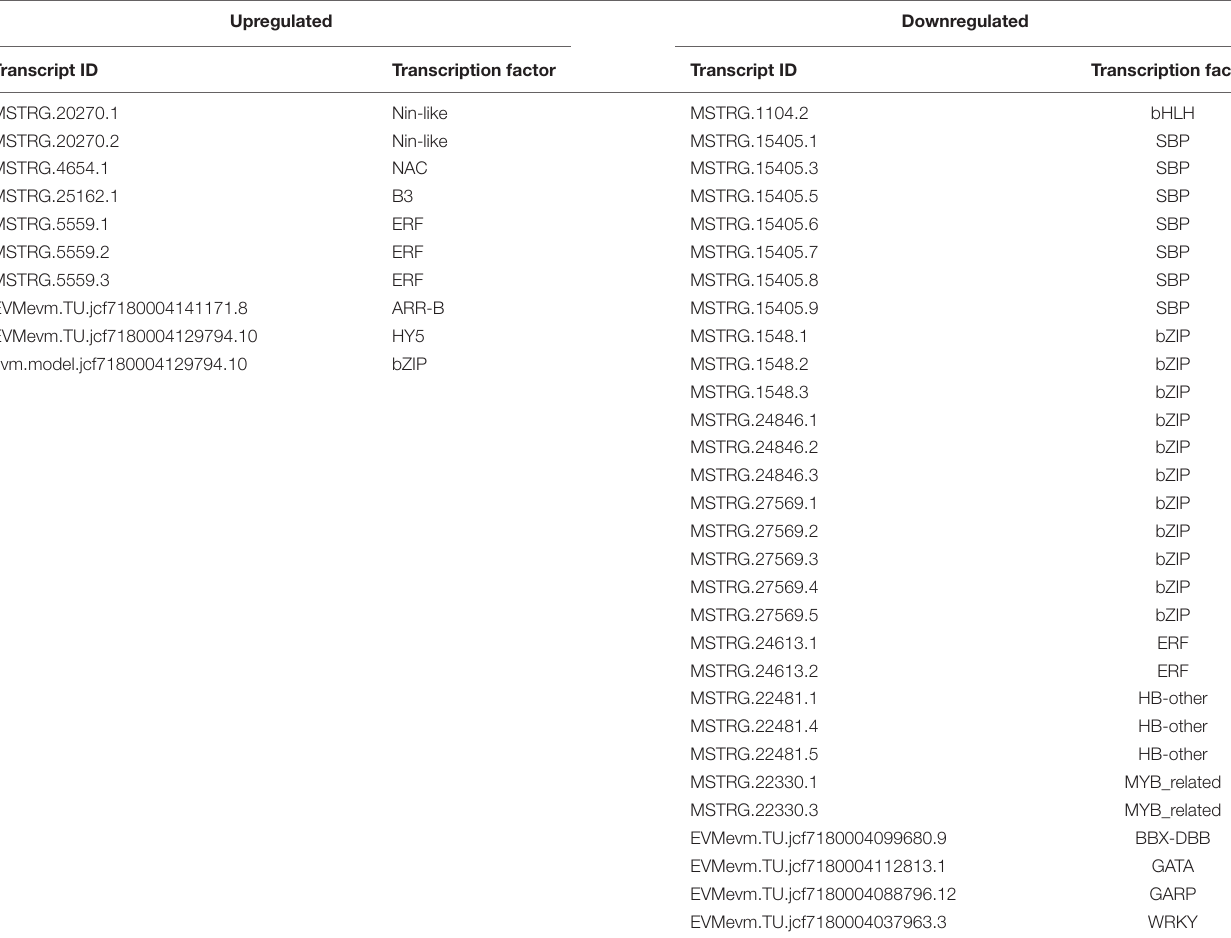
TABLE 3 | Transcription factors identified in differentially expressed